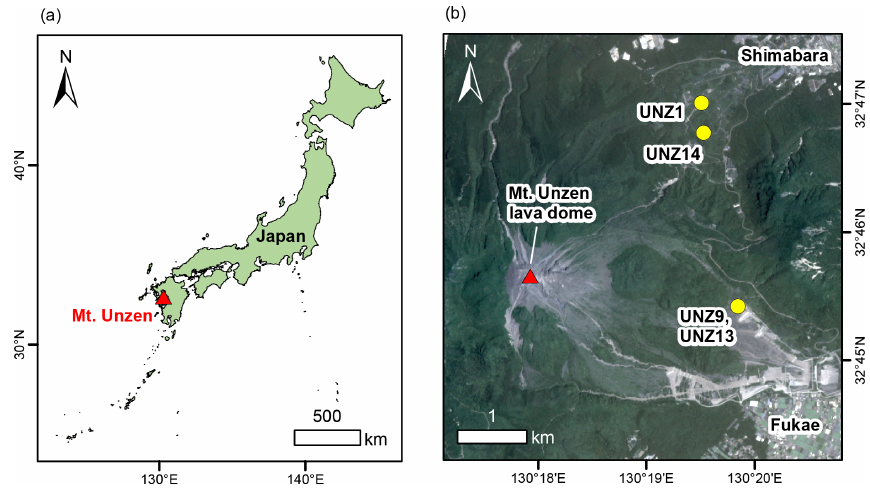
Figure 1. (a) Location of Mt. Unzen on the Shimabara Peninsula of Japan (country boundary data provided by the World Resource Institute). (b) Location of samples used in the study shown on top of a multispectral PlanetScope scene with 3m spatial resolution, from 7 June 2020 (Planet,